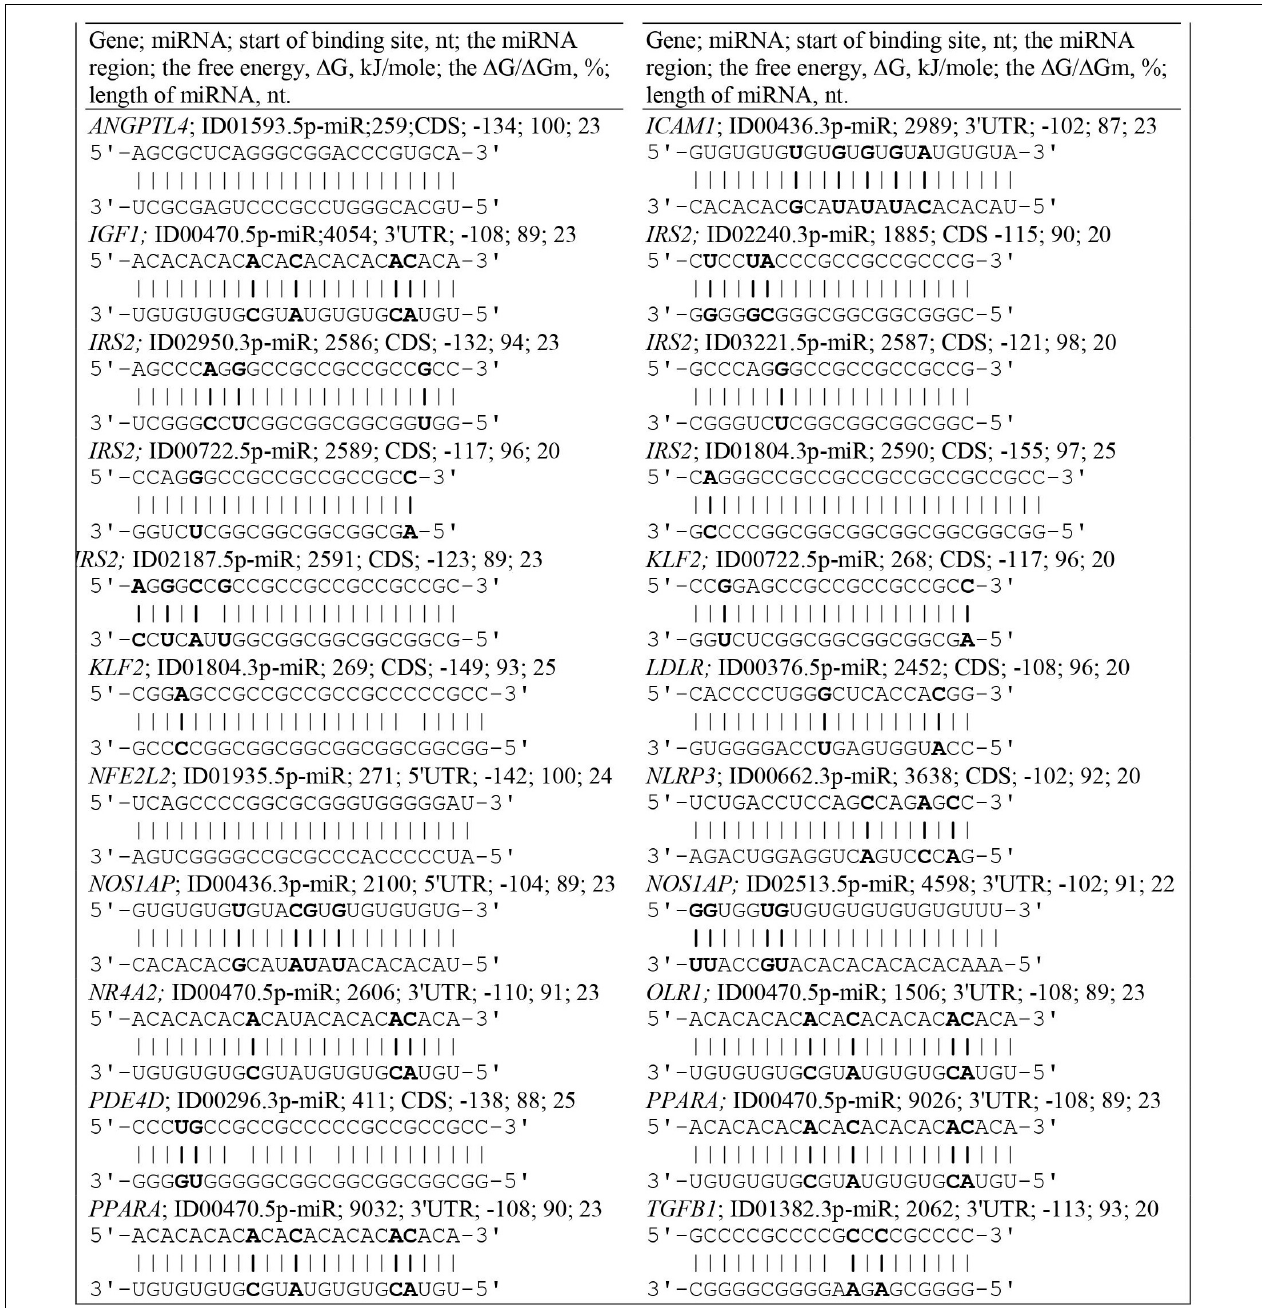
FIGURE 2 | Convincing evidence of the effectiveness of the MirTarget program in determining the characteristics of miRNA binding to the 5 (cid:48) UTR, CDS and 3 (cid:48) UTR of mRNA. The diagrams show the interaction of nucleotides along the entire length of the miRNA in the BS of the target mRNA and the characteristics of this interaction. Non-canonical base pairs are in bold.